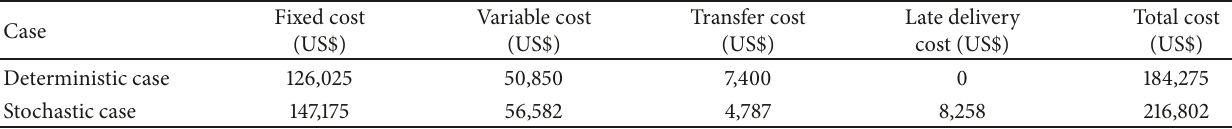
Table 7: Costs of the deterministic case and stochastic case.